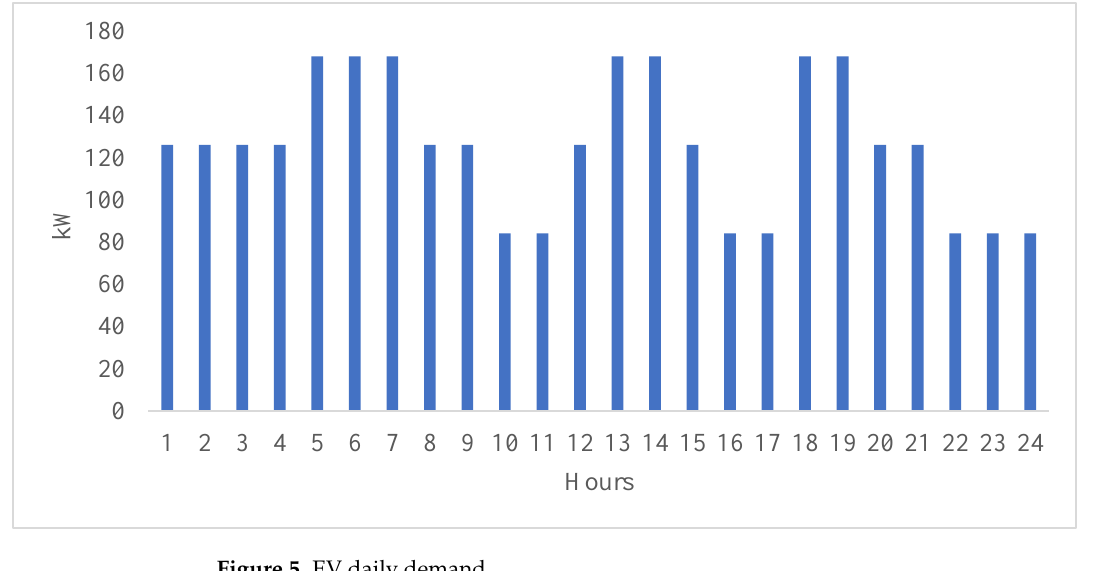
Figure 5. EV daily demand.